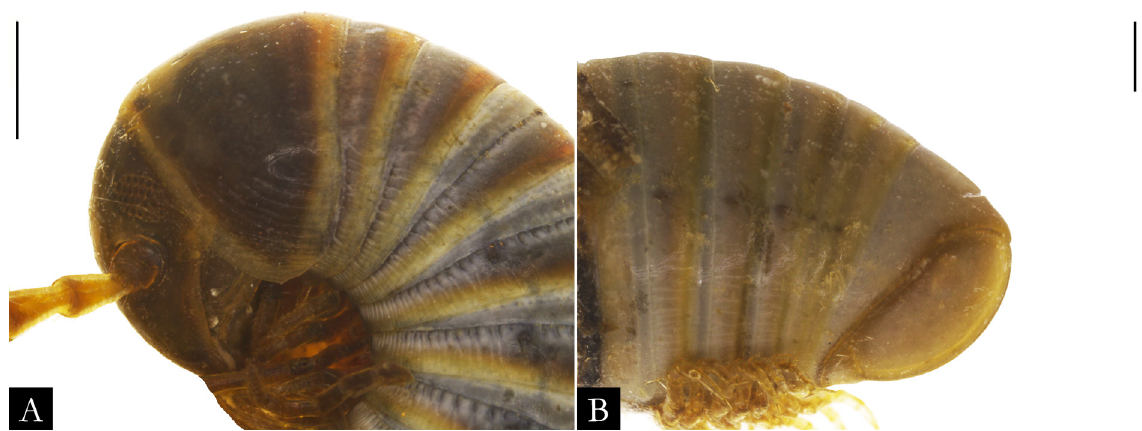
Fig. 64. Pseudonannolene curtipes Schubart, 1960, paratype. ♀ (MZSP 1022), in lateral view. A . Anterior region. B . Posterior region. Scale bars = 1